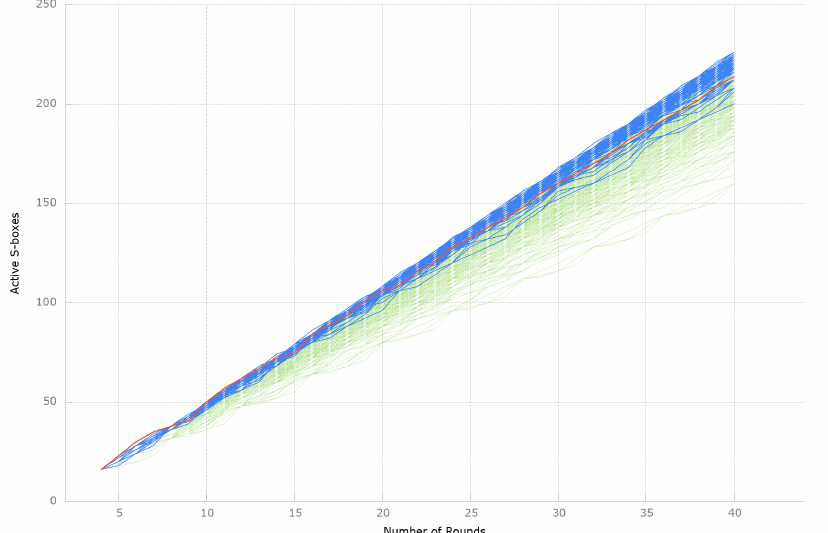
Figure 3: Bounds on the number of active S-boxes for the original Midori permutation (red), the permutations which reach at least once the optimal bound for 9 ≤ r ≤ 40 (blue) and all permutations which have an all-1 structure matrix (green). We did not consider permutations guaranteeing only 40 or less active S-boxes over 10 rounds, so optimal refers to the best bound over all permutations that have more than 40 active S-boxes over 10